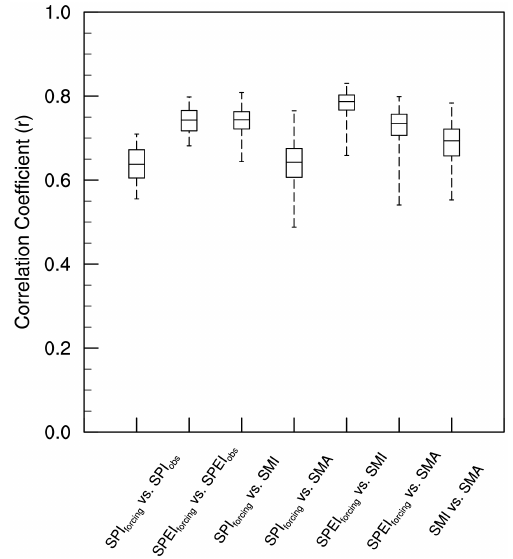
Figure 3. Percentiles of the time correlation coefficients across the grid boxes over Finland. The time correlations over the study period between the SPIs and SPEIs derived from the JSBACH forcing data and the observational data set (SPI forcing vs. SPI obs , SPEI forcing vs. SPEI obs ), and the time correlations between SPI, SPEI calcu- lated with the JSBACH forcing data and SMI, SMA calculated with the JSBACH simulated soil moisture (SPI forcing vs. SMI, SPI forcing vs. SMA, SPEI forcing vs. SMI, SPEI forcing vs. SMA), as well as the time correlation between SMI and SMA calculated with the JS- BACH simulated soil moisture (SMI vs. SMA), are investigated. Dashed lines extend from 5th to 95th percentile of the correlation coefficients over Finland, boxes extend from 25th to 75th percentile and middle horizontal lines within each box are the medians. Those correlation coefficients are statistically significant ( p <